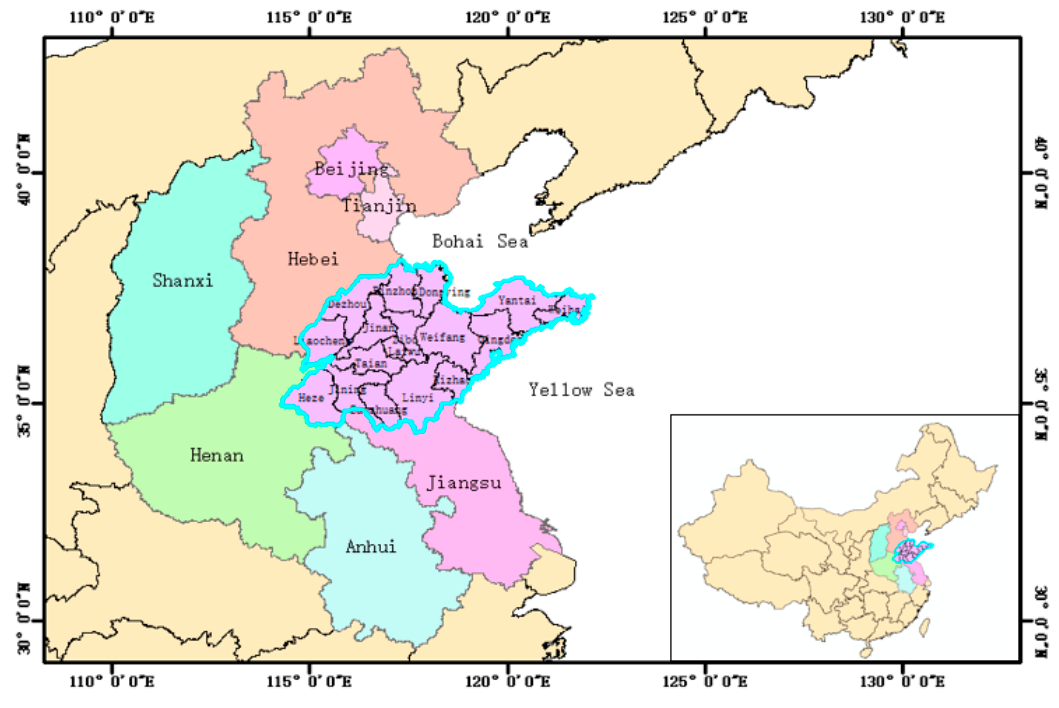
Figure 1. Shandong Province location map.